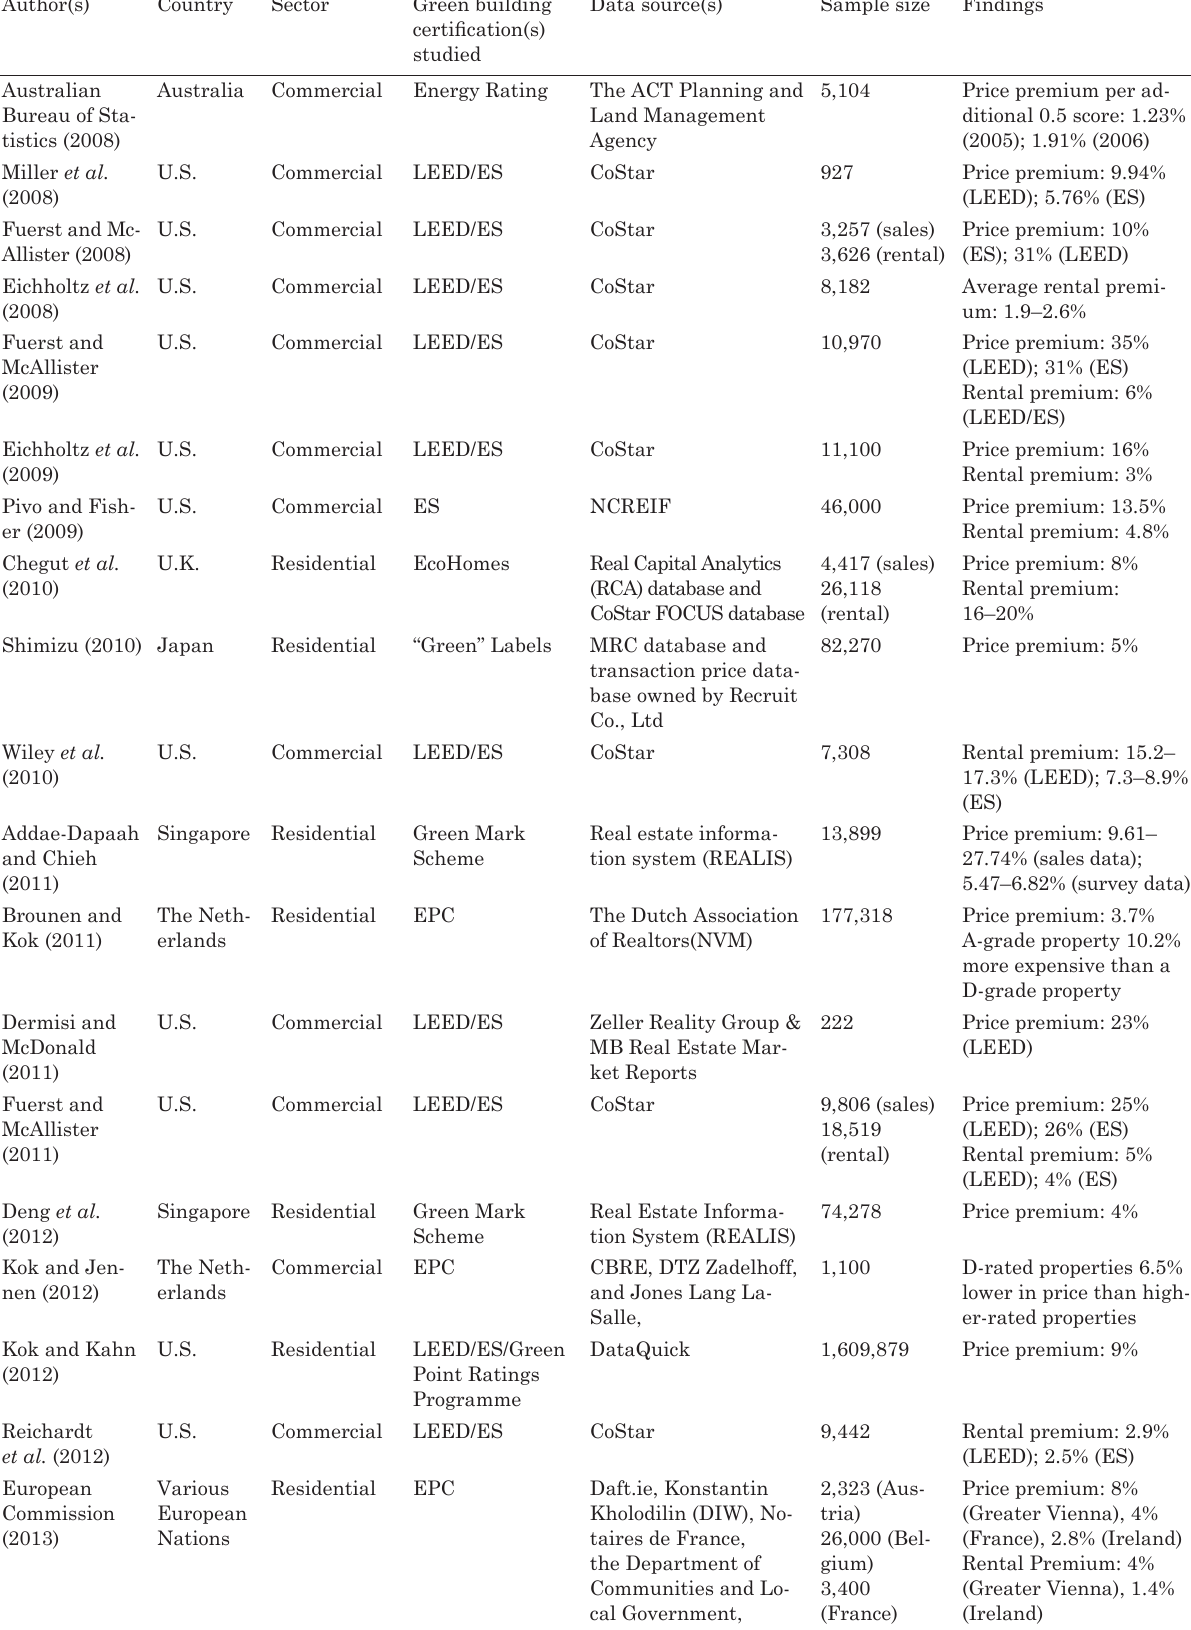
Table 3. Summary of previous studies on the impact of green certifications on property prices/rents